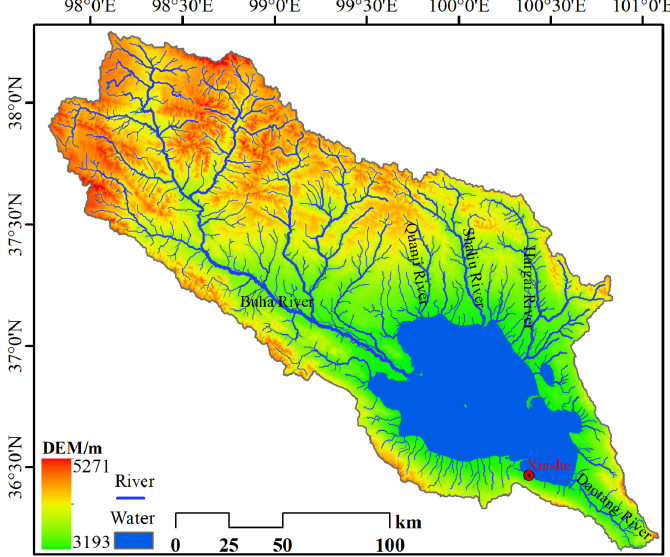
Figure 1. The location of Qinghai Lake.